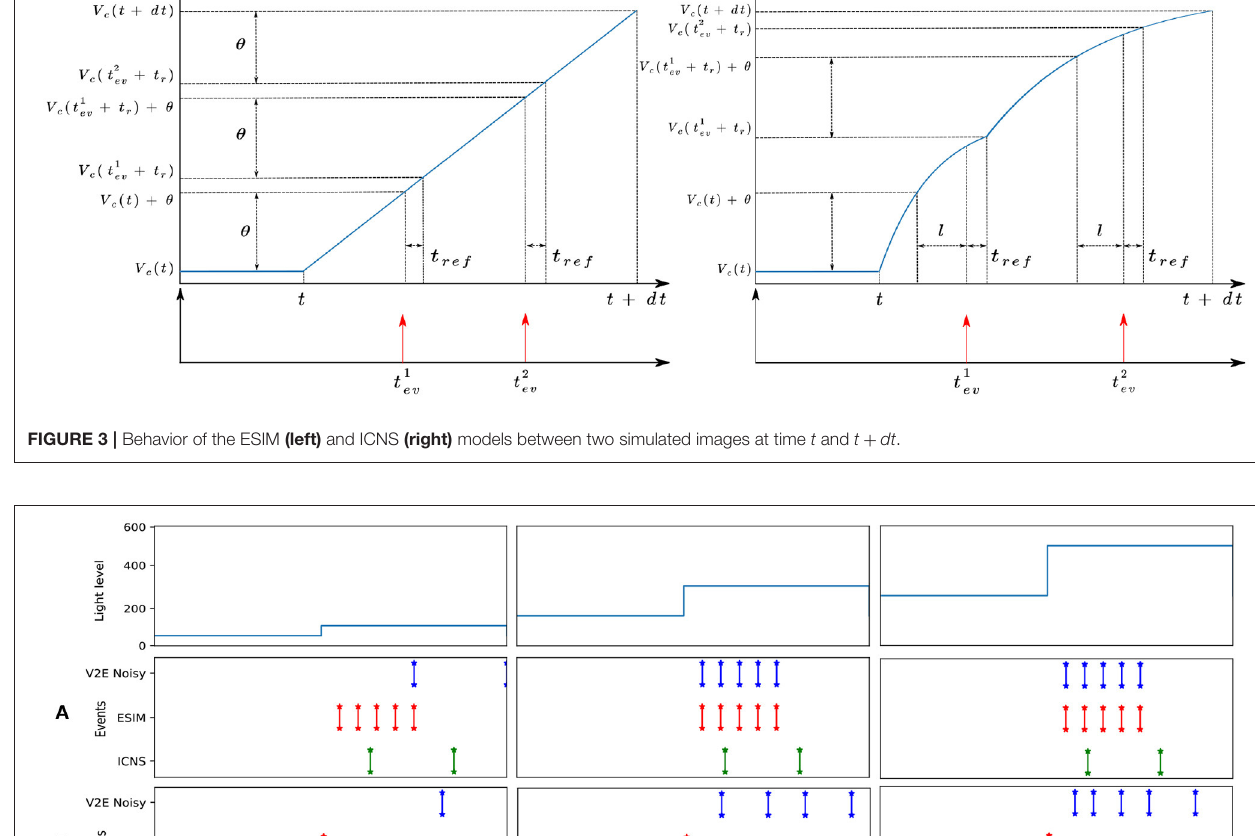
FIGURE 4 | Comparison of the response of the ESIM, ICNS, and V2E pixel when the light changes with a constant relative contrast equal to 200%, but different background light levels (50, 150, and 250). The contrast threshold is set to 0.15 (deviation 0.02). The temporal characteristics of the V2E pixel follows the noisy parameters (https://github.com/SensorsINI/v2e), except for the cutout frequency equals to 300 Hz. The parameters of the ICNS model’s latency are l τ l 500 µ s . For (A) , dt 500 µ s , and (B) , dt 50 µ s = = =